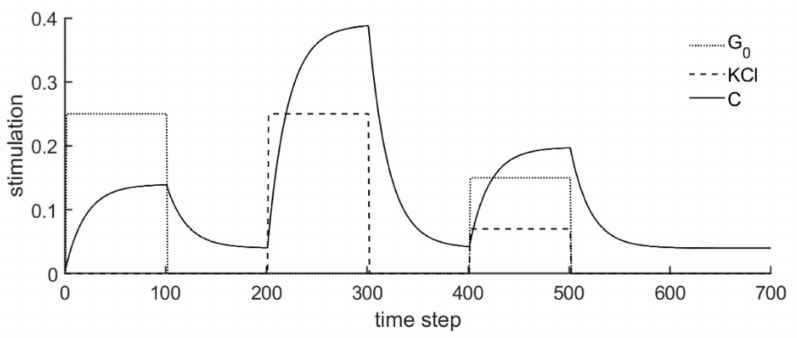
Figure 7. Example of the dynamic behavior of the calcium concentration on di ff erent stimuli according to Equation